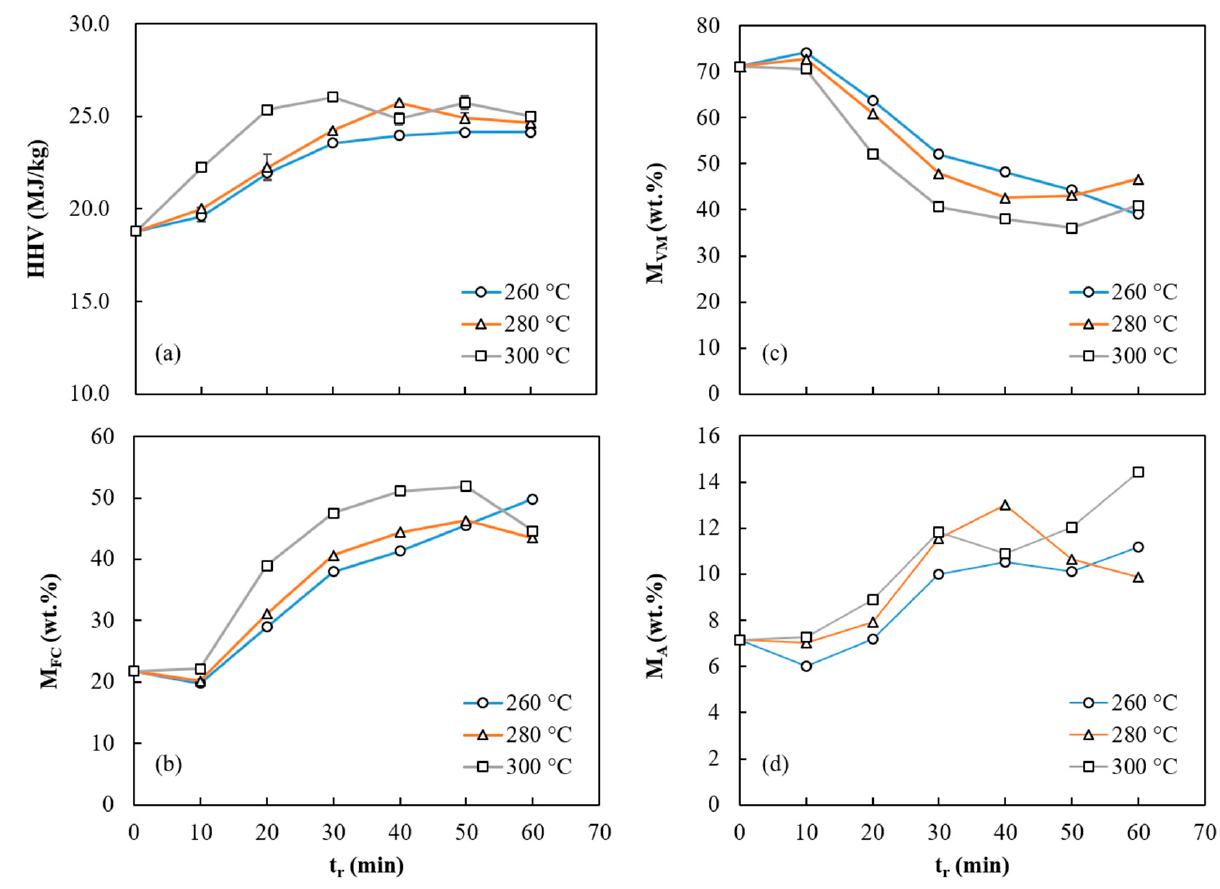
Figure 3. Analyses of calorific value and proximate for JMS T in different operating conditions: ( a ) HHV, ( b ) M FC , ( c ) M VM, and ( d ) M A